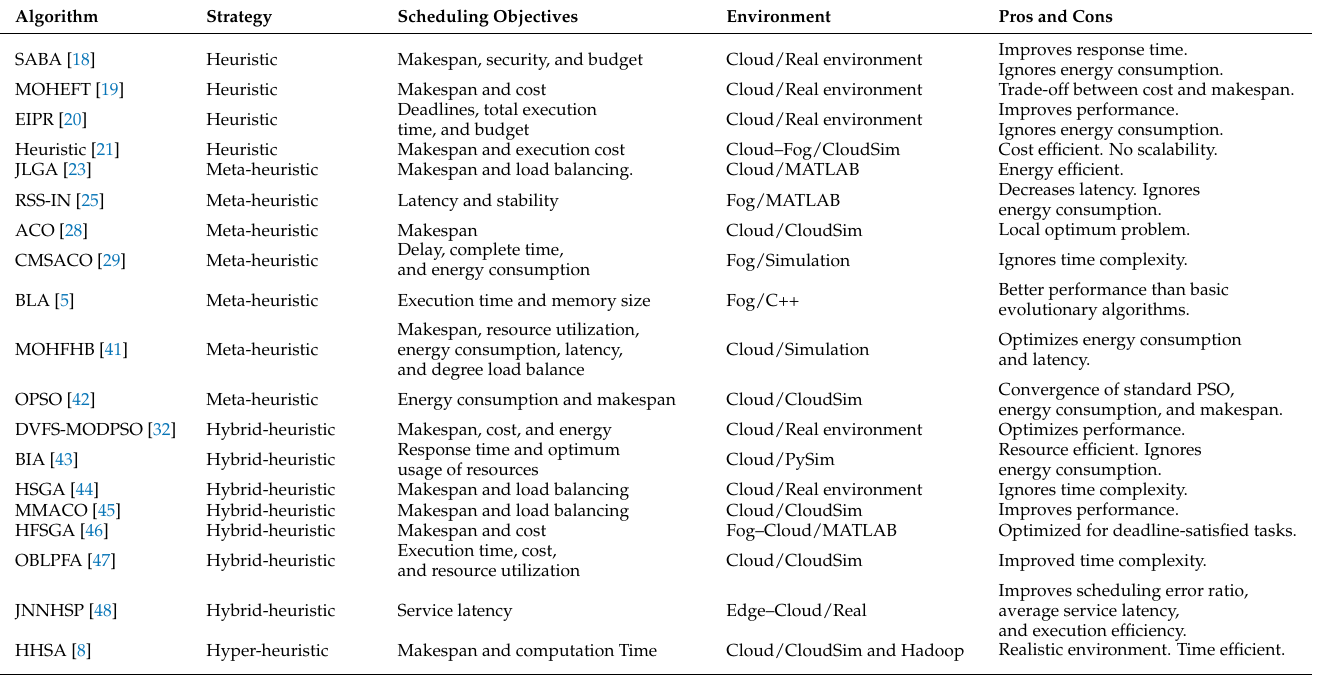
Table 1. Categorization of task-scheduling